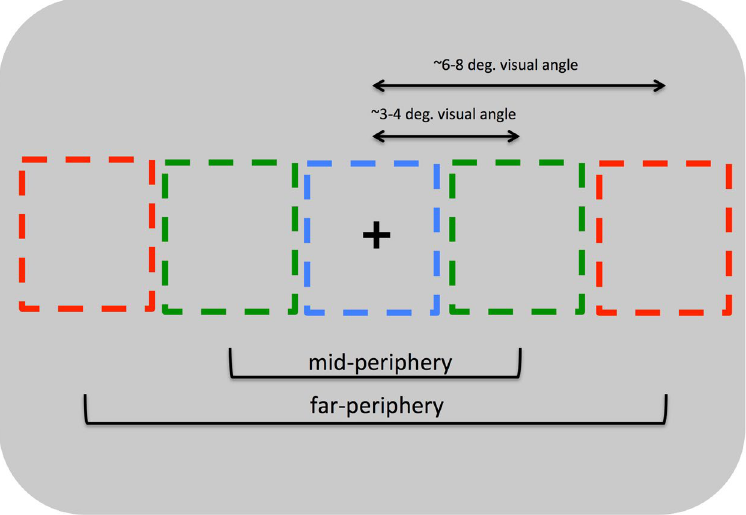
and 2 (red rectangle), or at an intermediate eccentricity (green rectangle). Image size was not manipulated in this experiment.